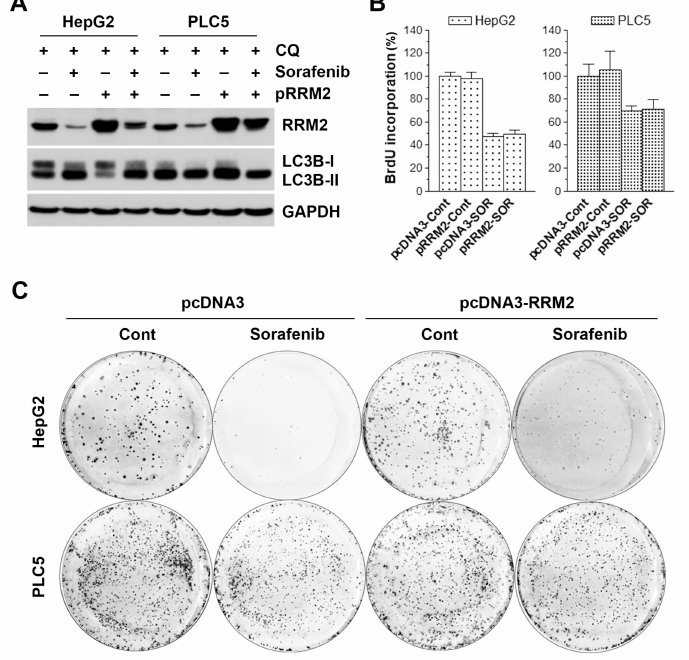
Figure 5. E ff ect of ribonucleotide reductase regulatory subunit M2 (RRM2) overexpression on sorafenib-induced cell death in hepatocellular carcinoma (HCC) cells. HepG2 and PLC5 cells were transfected with RRM2-encoding (pRRM2 or pcDNA3-RRM2) or control plasmid (pcDNA3). After 24 h, cells were treated with 5 µ M sorafenib (SOR) for 48 h for Western blot analysis ( A ), BrdU cell proliferation assay ( B ), and colony formation assay ( C ). In ( A ), 30 µ M chloroquine (CQ) was added to cell culture 6 h before cell harvest. In ( C ), cells were washed twice with PBS after sorafenib treatment. Cells were further cultured for an additional 10 to 14 days for colony